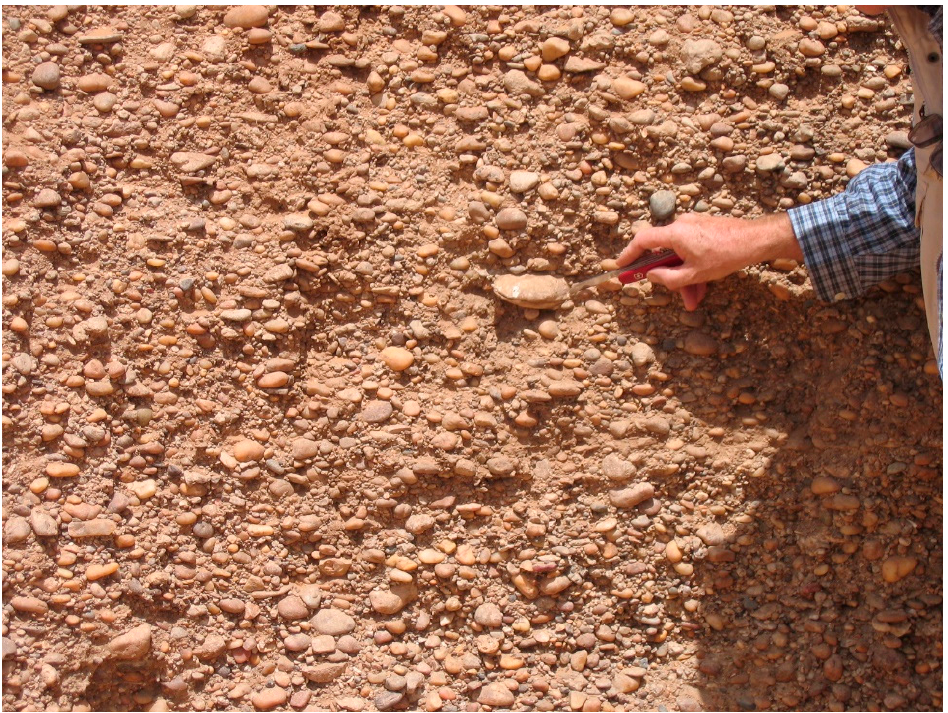
Figure A2. Alluvial pebbles and gravels laid down by the Nile in northern Sudan 20,000 years ago. The bivalve shells are a freshwater Nile mussel, most probably Mutela sp.